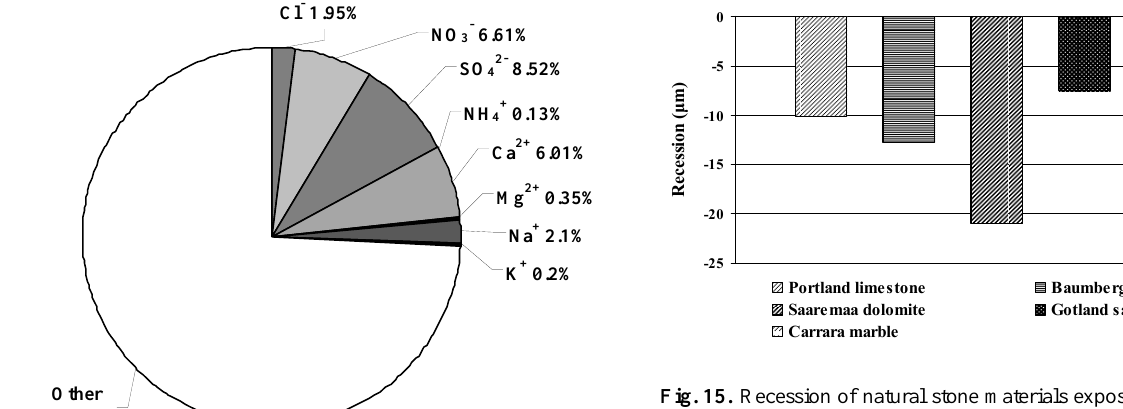
Fig. 15. Recession of natural stone materials exposed for one year under unsheltered conditions.